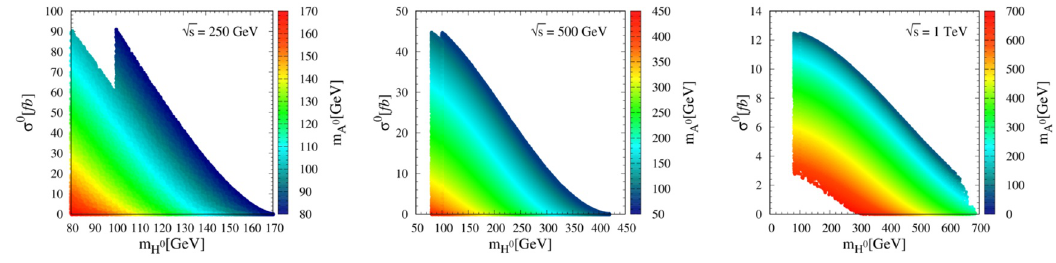
Figure 13 . In Scenario II, tree level cross sections for e + e − → H 0 A 0 are shown as a function of and m for various CM energy: m H 0 A 0